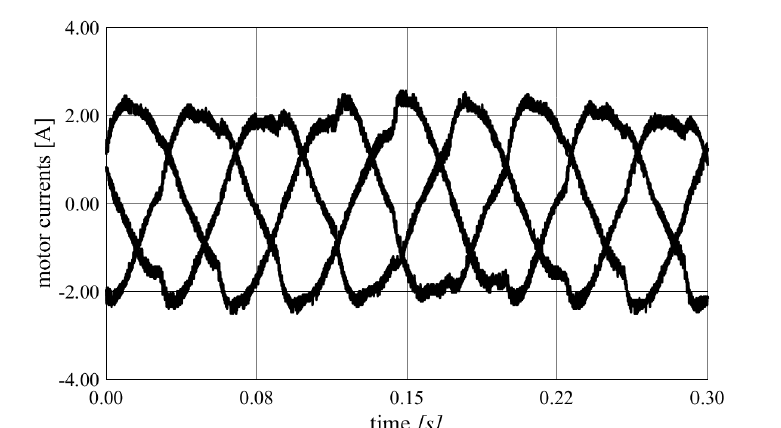
Figure 12. Experimental result: motor currents achieved with the traditional SVM, when m = 0.27, v ∗ = v ∗ = 200 V, and T l = 3.5 C1 C2